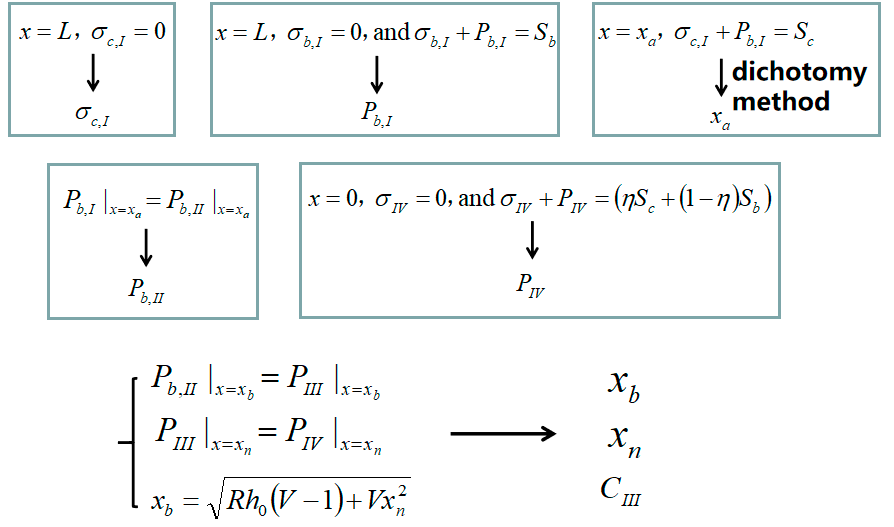
Figure 6. Solution diagram of x b , x n and C III